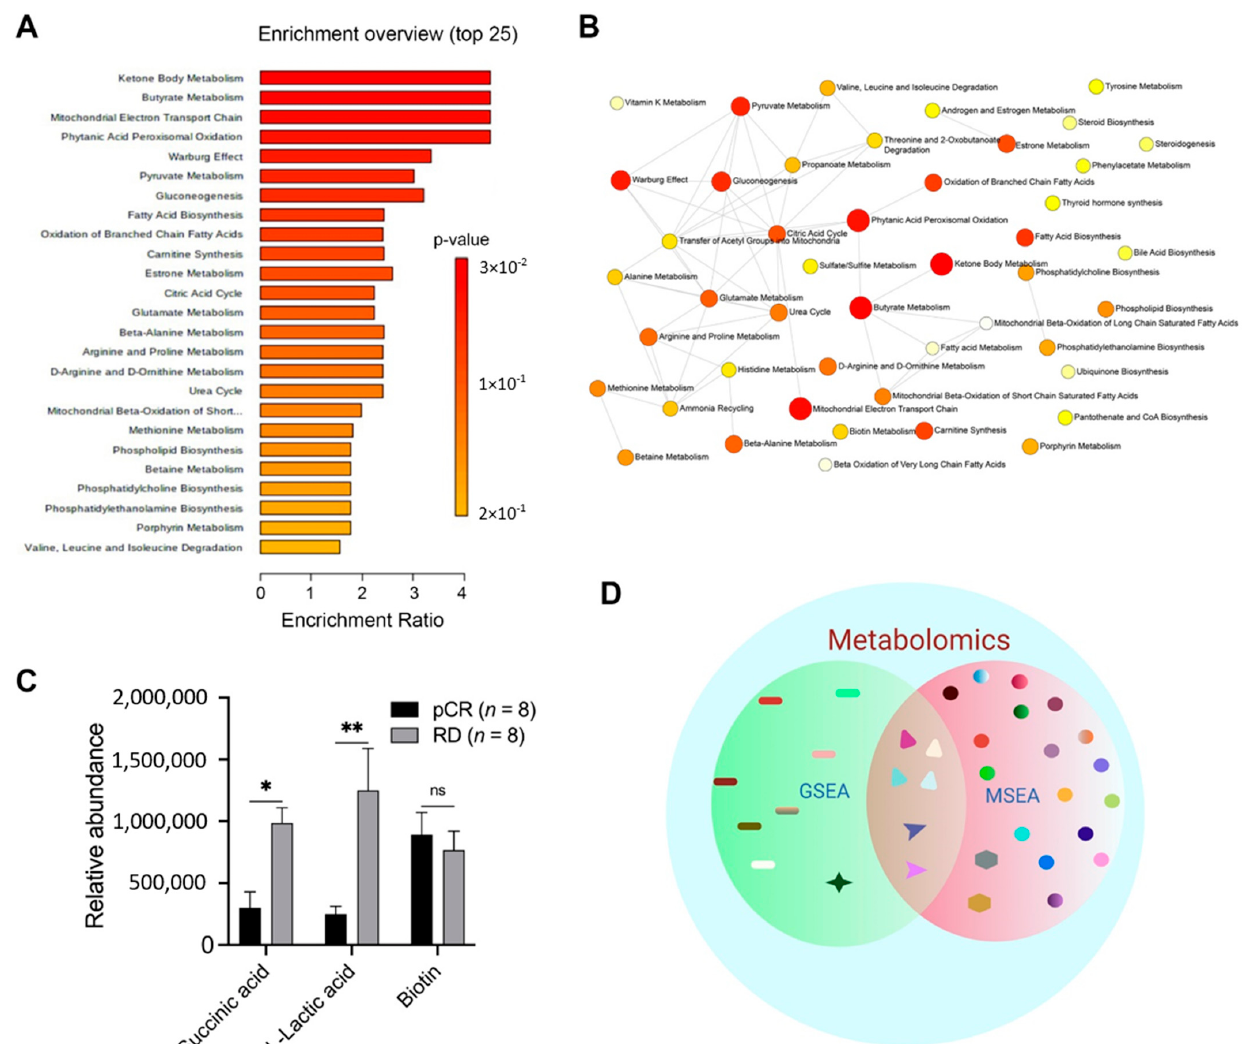
Figure 3. Succinic acid and L-lactic acid are significantly upregulated in plasma exosomes of patients with RD after NAC. Differentially regulated metabolic pathways and metabolites were identified using MSEA. ( A ) Network showing metabolic pathways differentially regulated in patients with RD or pCR after NAC. ( B ) Summary plot showing the top 25 differentially enriched metabolic pathways. Each node represents a metabolite set with its color based on its p -value and its size based on number hits to submitted query. Two metabolite sets are connected by an edge if the number of their shared metabolites is over 25% of the total number of their combined metabolite sets. ( C ) Bar graphs showing the levels of various metabolites in patients with RD and those with pCR. ( D ) Venn diagram showing common metabolites identified using GSEA and MSEA. Bars indicate mean ± SEM. Two-way ANOVA with Sidak’s multiple comparison test was used to determine statistical significance. ns, non-significant; * p < 0.05; ** p < 0.005; The scheme in ( D ) was created using Bi-oRender, Toronto, ON,